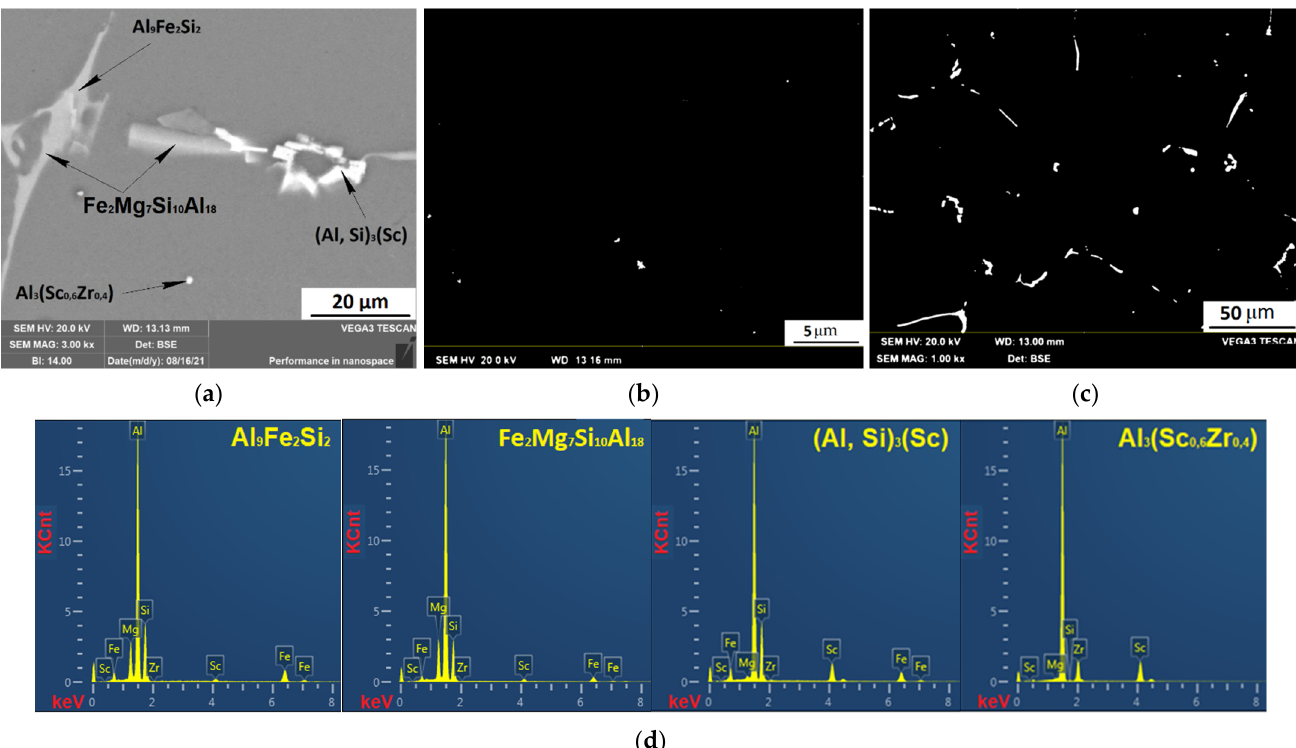
Figure 7. Al 0.3 Mg 1 Si 0.3 Sc 0.15 Zr main types of intermetallic compounds ( a ); small dispersoids ( b ); large particles ( c ); result of the EDS investigation of chemical composition of the intermetallic compounds ( d ).